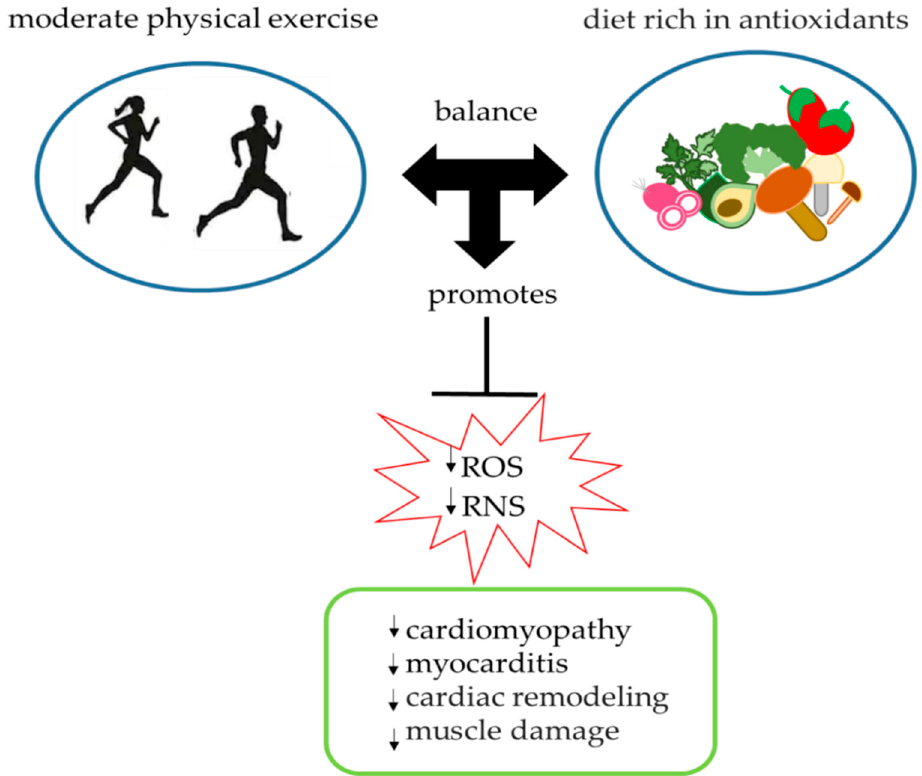
Figure 6. Correlation between the intake of foods rich in sulfur compounds and physical activity.